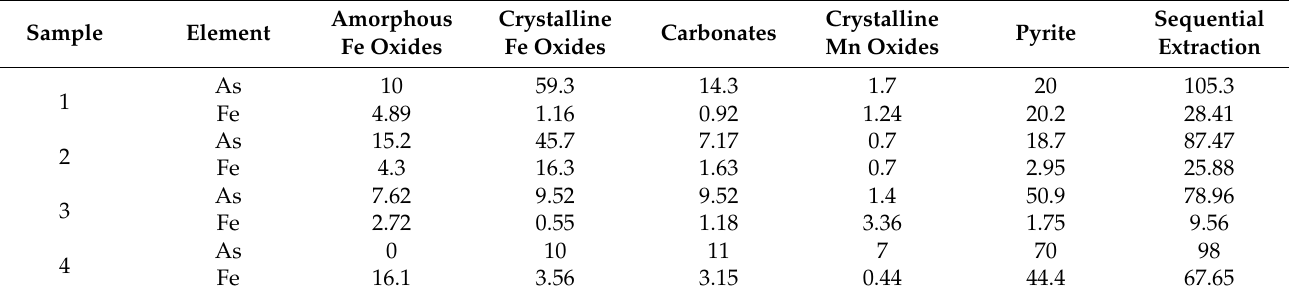
Table 5. Summary results, Selective Extraction